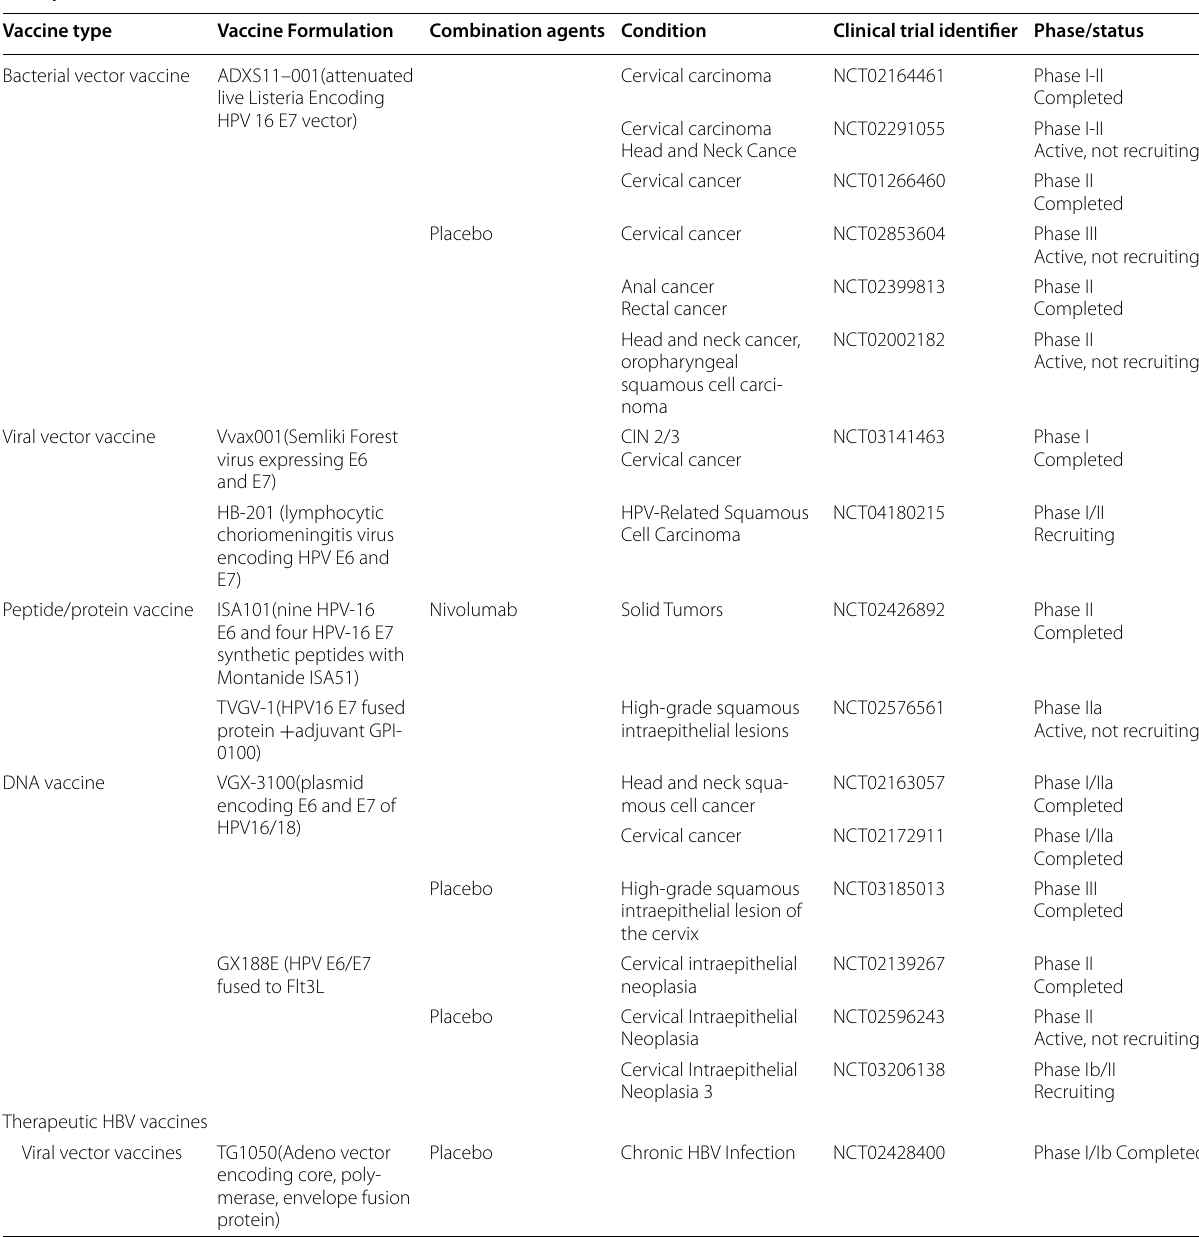
Table 1 Selected clinical trials of therapeutic vaccines against infectious disease Therapeutic HPV vaccines Vaccine